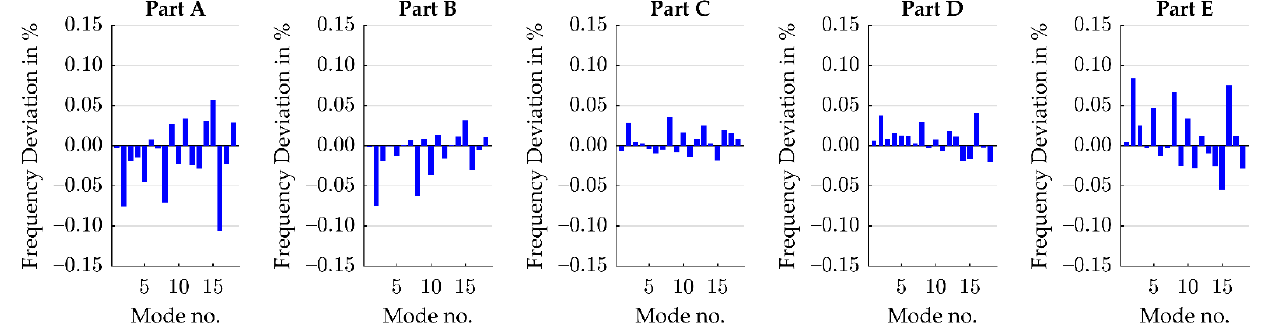
Figure 9. Relative deviations of initially simulated and then with correction factors adapted eigen- frequencies to measured eigenfrequencies (the diagrams show the adaption for in each case one reference part, that means for part A, B, C, D, or E, based on factors derived from the other